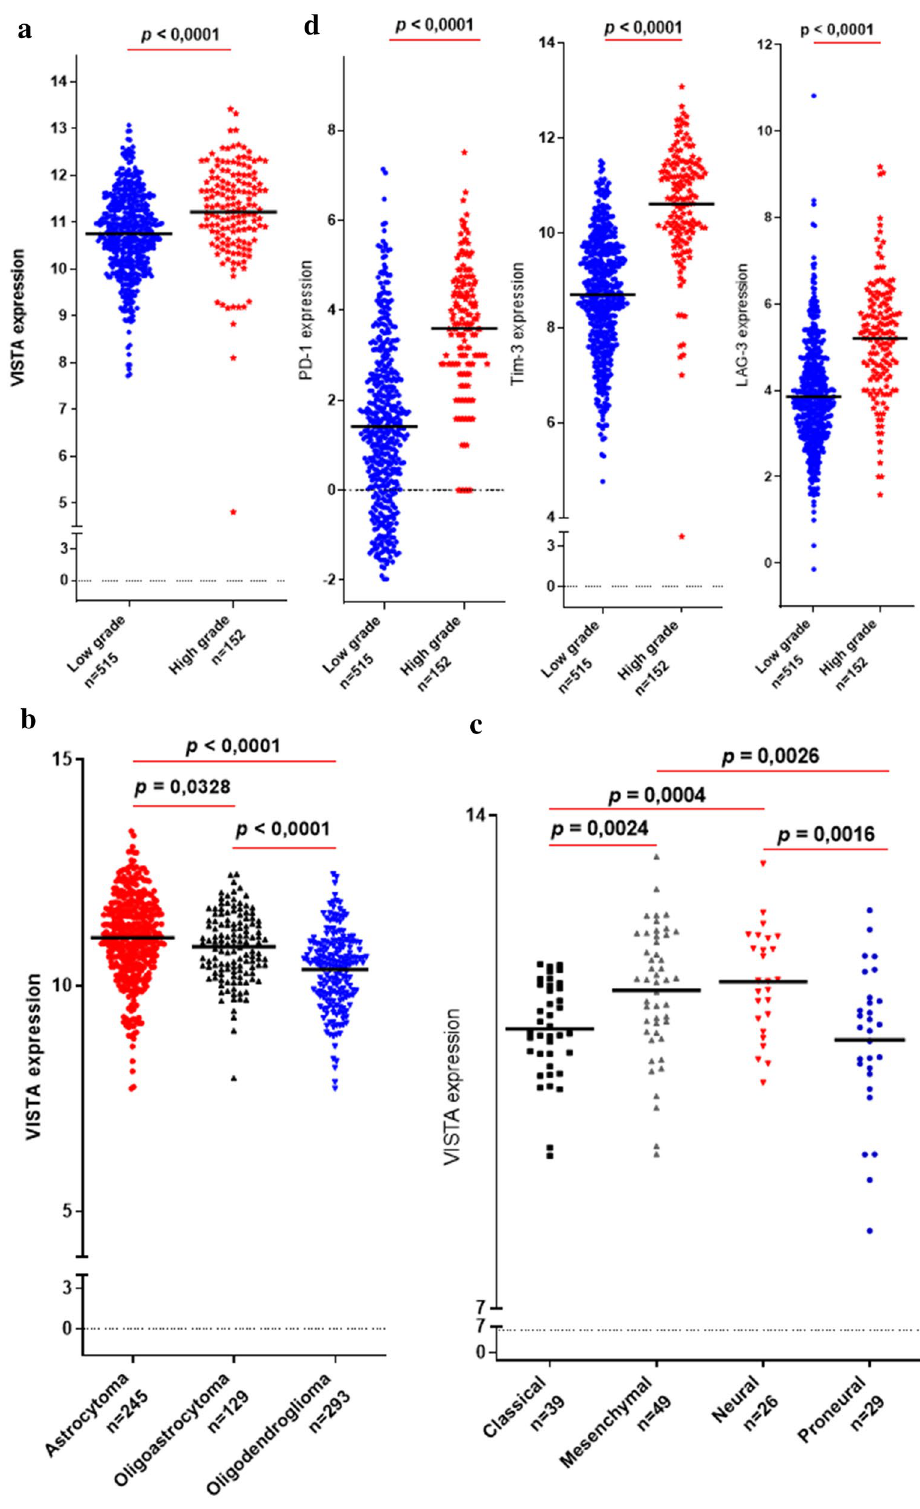
Figure 3. VISTA transcripts strongly expressed in high glioma grades in the TCGA cohort and positively correlated with critical immune checkpoint regulators. RNAseq of 667 glioma patients of different grades were analyzed using TCGA dataset. ( a ) VISTA mRNA evaluation revealed high expression in advanced gliomas (grade IV). ( b ) Astrocytomas showed elevated expression of VISTA compared to oligoastrocytomas and oligodendrogliomas. ( c ) Mesenchymal and Neural glioma subtypes presented high VISTA expression in comparison with classical and proneural. ( d ) PD-1, Tim-3 and LAG-3 were upregulated in high grade glioma (glioblastoma).T-test was applied to compare gene expression between different grades and groups of glioma patients. p value less than 0.05 was considered as statistically significant for all statistical